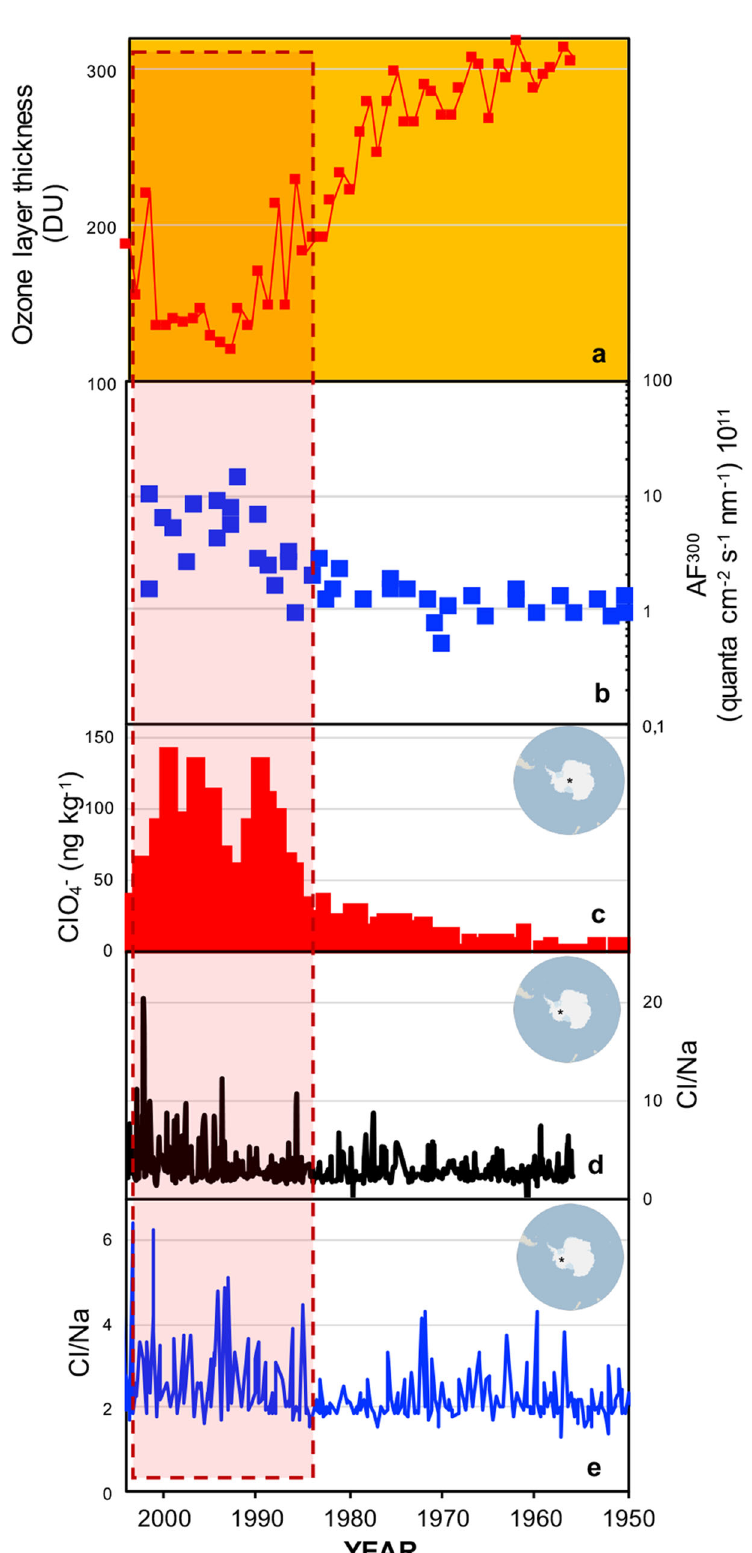
Fig. 5 The impact of the modern enhanced UV-B radiation on chlorine chemistry in Antarctic ice cores. a Temporal variability of October mean total ozone column over the Antarctic region in Dobson (DU) units; ( b ) the modeled radiative light that affects the Antarctic surface due to ozone hole formation by mean sunlit Actinic Flux at 300 nm 49 ( c ) Perchlorate concentrations in the Geographic South Pole ice core 50 ; ( d ) reanalysis from Cl/Na in a WAIS core 53 ; and ( e ) the temporal pro fi le of the Cl/Na ratios for the period 1950 – 2004 at Mount Johns 54 .